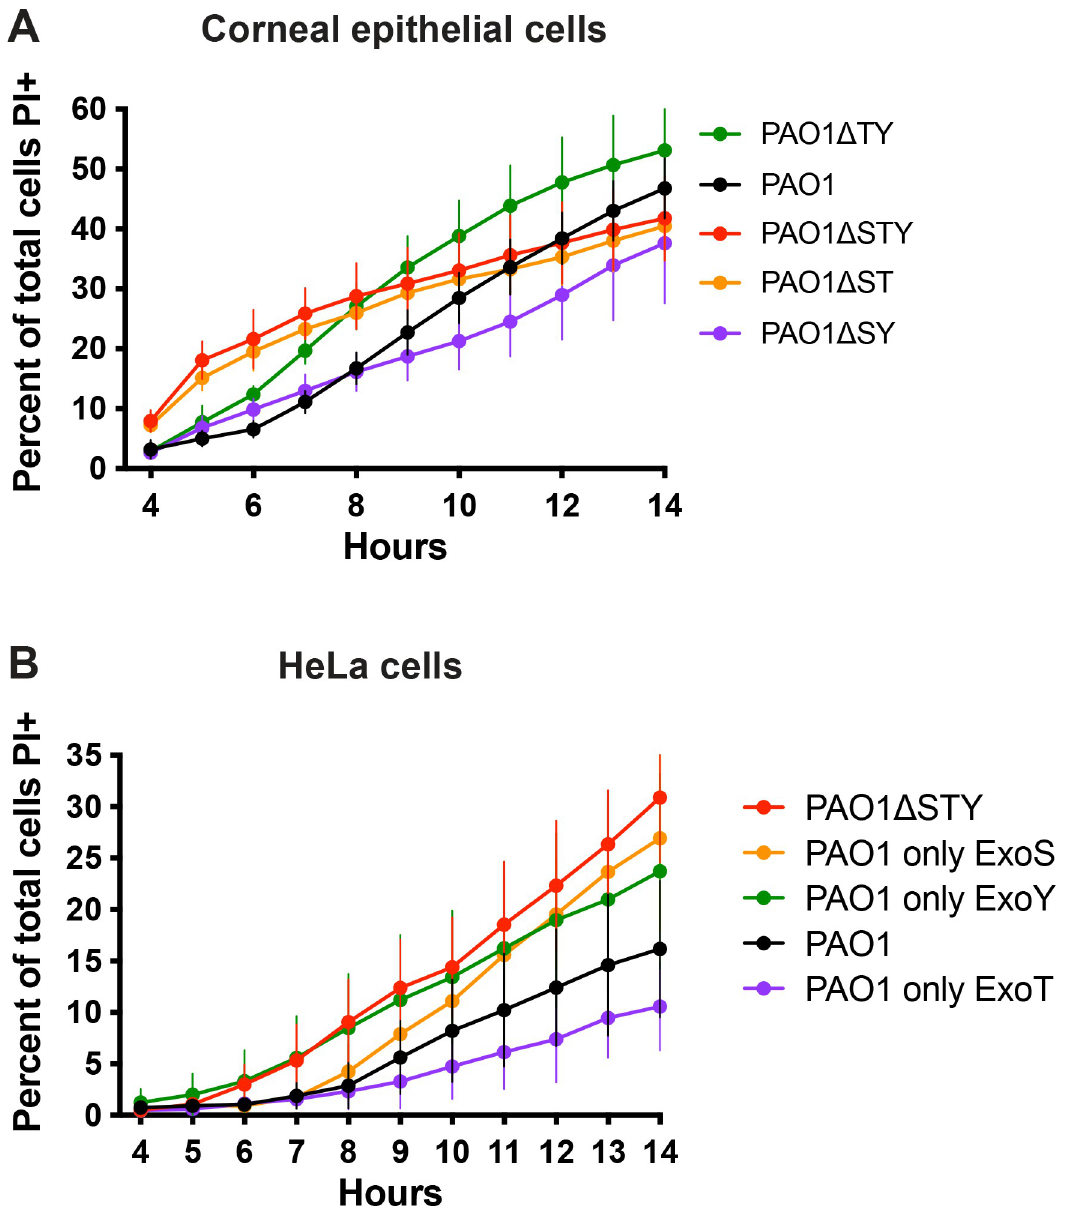
Fig 3. ExoT and ExoS improve survival time of infected cells over the effector-null mutant. Corneal epithelial cells (hTCEpi) (A) or HeLa cells (B) were infected with PAO1, PAO1 Δ exoSTY , or mutants missing two of three known effectors for 3 h, then extracellular bacteria eliminated with amikacin. Hoechst and PI were included in the media. Time-lapse images were captured once per hour. Hoechst-positive and PI-positive nuclei were counted at each time point with an ImageJ macro. Data expressed as mean ± SD. Results shown are combined from at least three independent